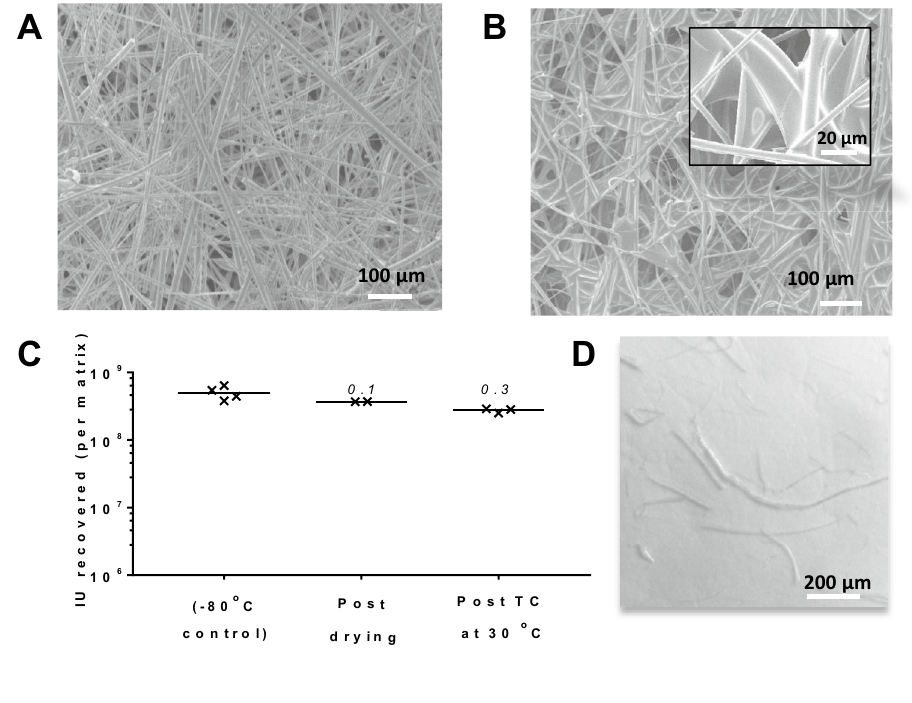
Figure 2. SMT on S14 results in thermostable vaccine embedded in sugar glass. ( A ) and ( B ) show scanning electron micrographs of S14, respectively before and after loading and drying of 0.5 M (80:20) trehalose:sucrose. In panel ( A ), the arrangement of fibres in S14 is apparent (× 200 magnification, 100 µm scale bar). In panel ( B ), sugar glass films are visible between fibres (main panel at × 200 magnification with 100 µm scale bar, inset at × 1000 magnification with 20 µm scale bar). Panel ( C ) shows recovery of vaccine from matrix loaded with a human dose of adenovirus, both immediately post-drying and after thermochallenge at 30 °C for 1 month. Results plotted illustrate total virus recovery from each replicate matrix (n = 4 for − 80 °C comparator, n = 2 for post-drying, n = 3 for post-thermochallenge), with lines indicating the mean of the replicates. Numbers above each result show log 10 -fold loss from the − 80 °C control. Panel ( D ) shows a representative light microscopy image of fibres shed from S14 after vaccine reconstitution (scale bar 200